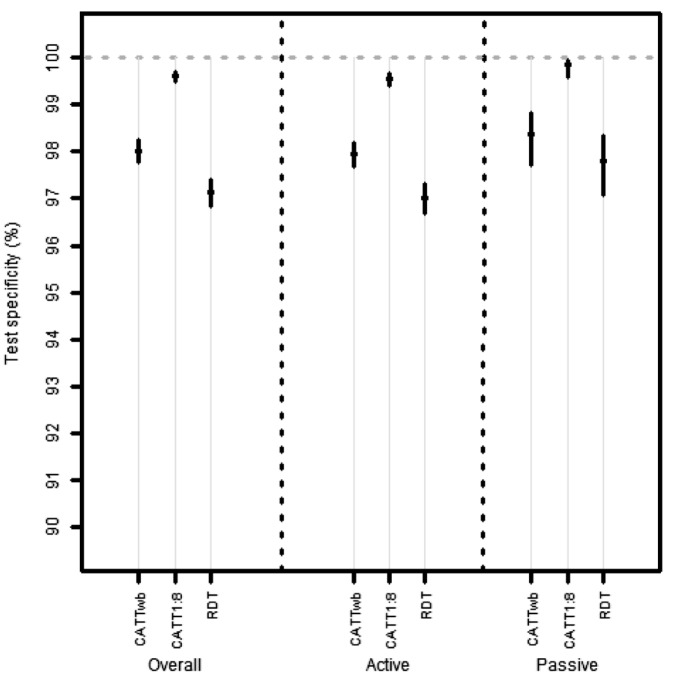
Specificity of the tests.Points represent the estimates and lines the 95% CIs. Note the y-axis range is 90–100%. Active and passive refer to active and passive screening.